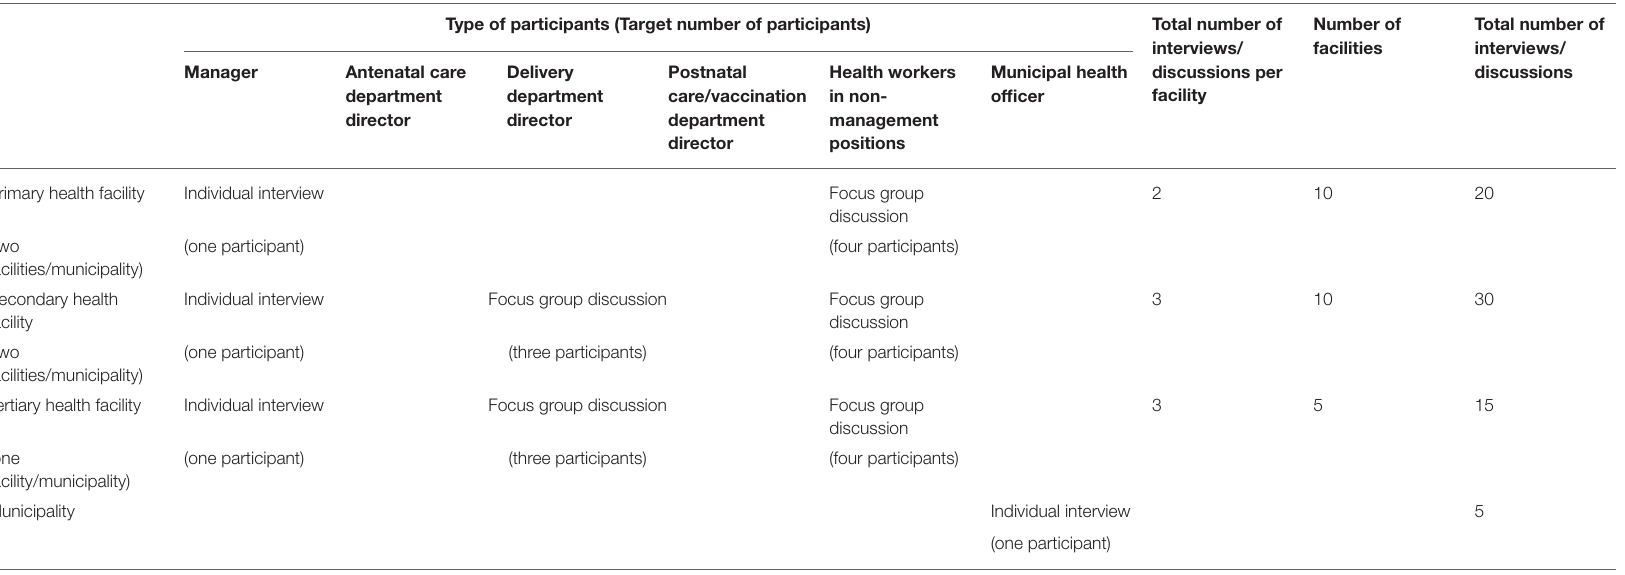
TABLE 1 | Interview/focus group discussion participants and the total number of interviews/focus group